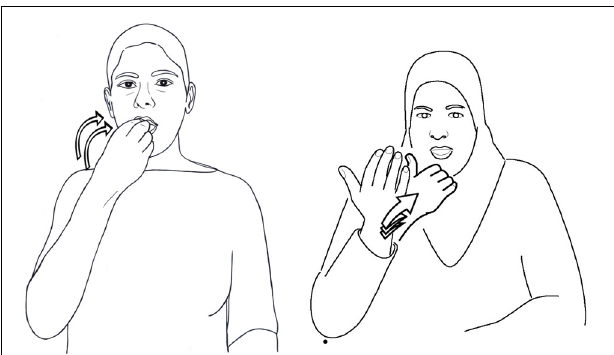
FIGURE 4 | Comparison of lexical similarity between ISL, KQSL, and